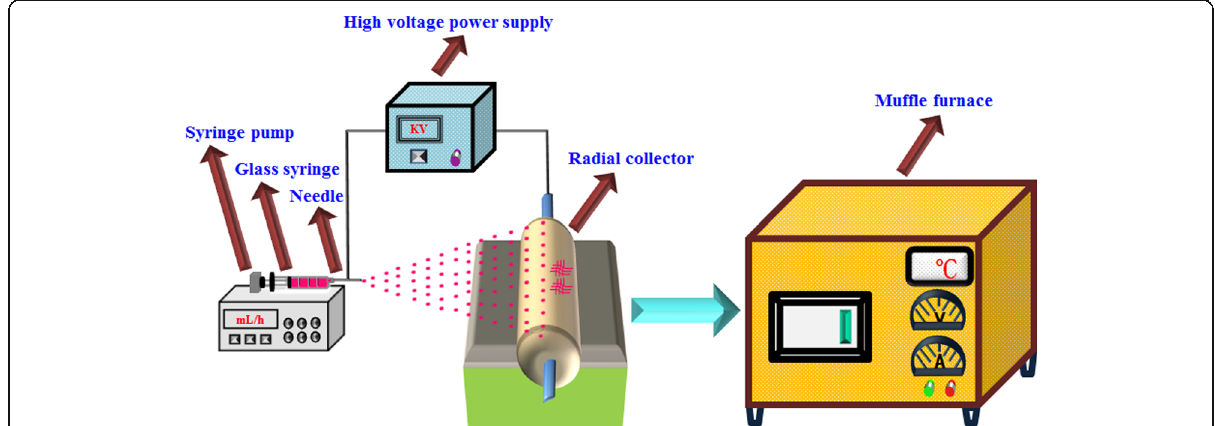
Fig. 1 Schematic diagram of the preparation process of